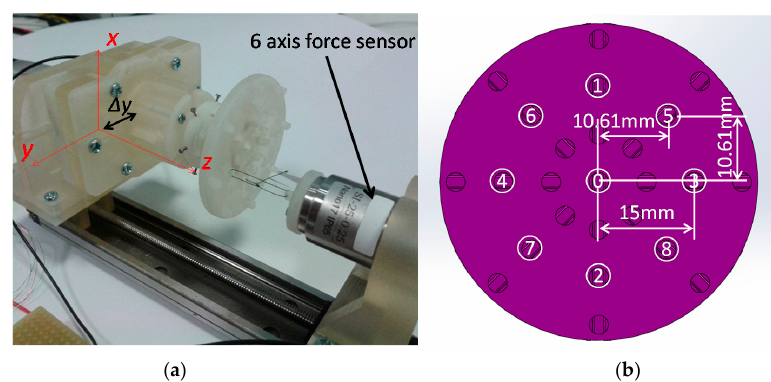
Figure 12. Sensor calibration device: it can apply compressive force by a load tip and tensile force by a wire, at the numbered points on the load fixture. ( a ) Sensor calibration device; ( b ) Detail description of the load fixture as shown in Figure 11.